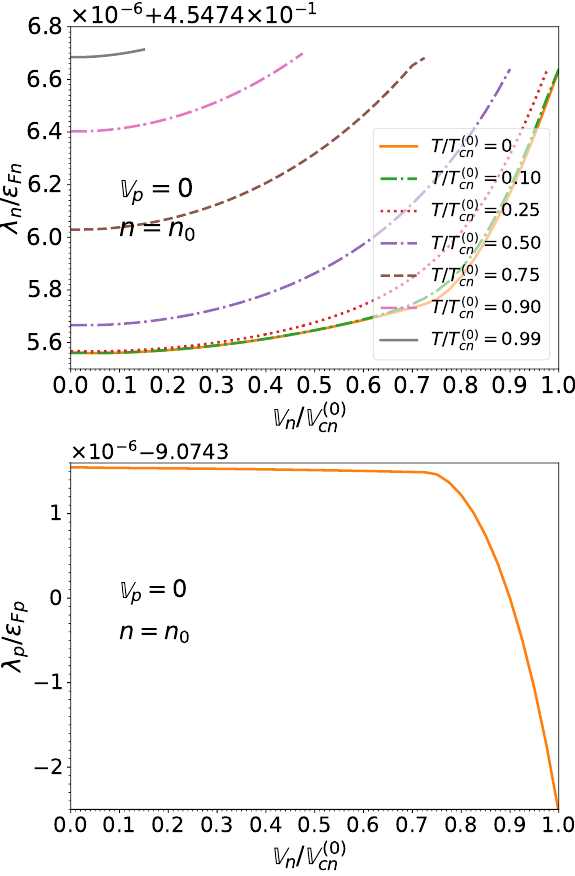
Figure 19. Same as Figure 18 at the saturation density n 0 . Please note that for the proton chemical potential λ p , results for temperatures (ranging from 0 to T the solid